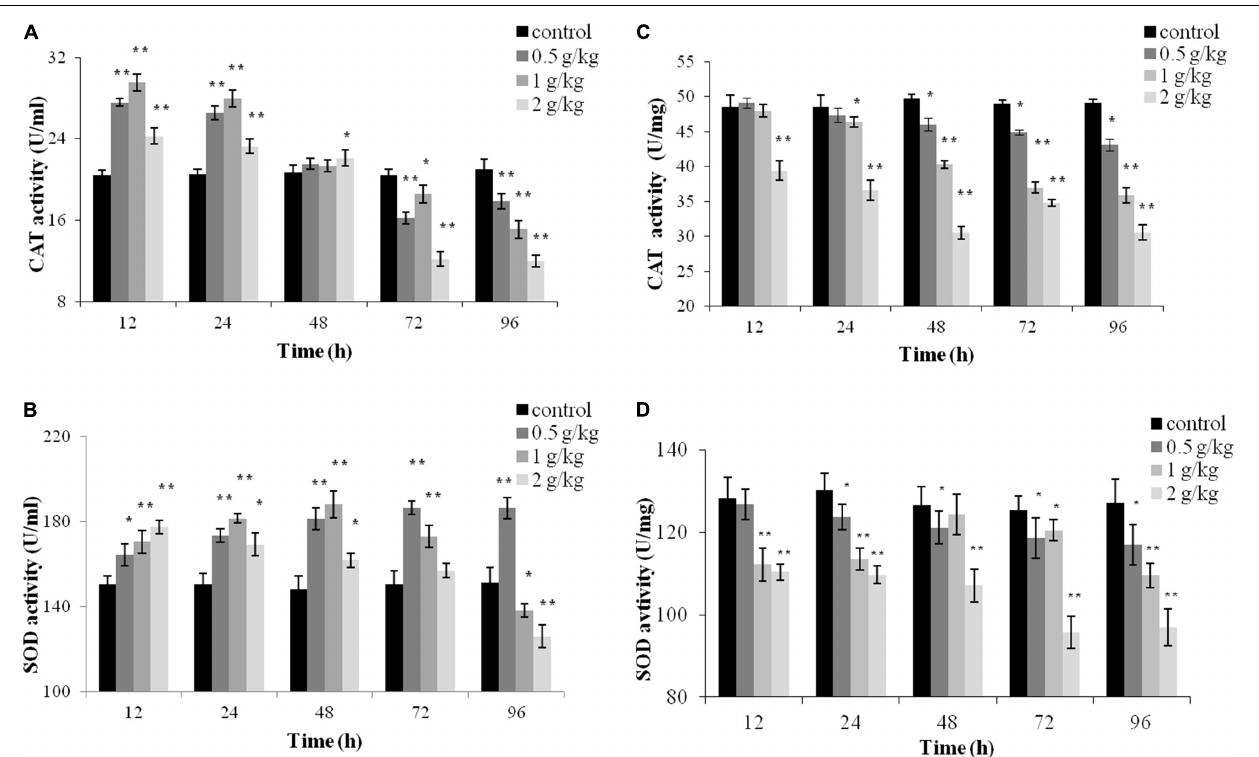
FIGURE 4 | Catalase (CAT) and superoxide dismutase (SOD) activities of Carassius auratus gibelio after a single dose of 0.5 g/kg, 1 g/kg, or 2 g/kg trichlorfon. (A) Changes in CAT activity in plasma after a single dose of trichlorfon; (B) changes in SOD activity in plasma after a single dose of trichlorfon; (C) changes in CAT activity in liver tissues after a single dose of trichlorfon; and (D) changes in SOD activity in liver tissues after a single dose of trichlorfon. Asterisks indicate values that are significantly different from the control values, ∗ P < 0.05; ∗∗ P < 0.01, n =